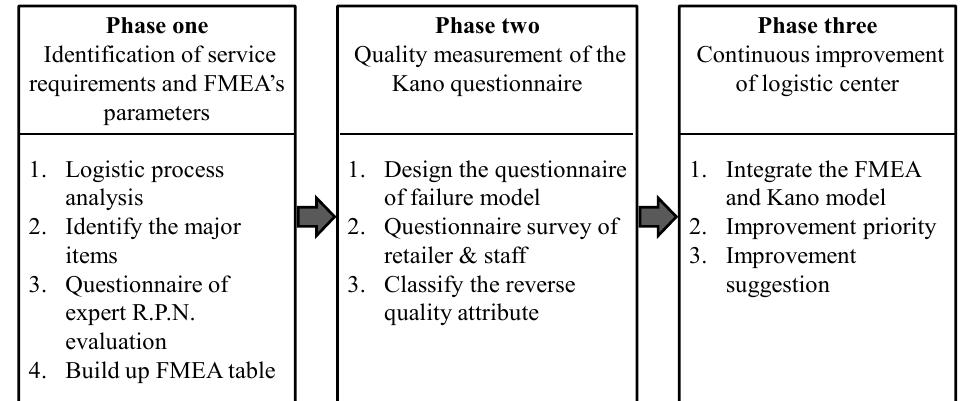
Figure 1. Research